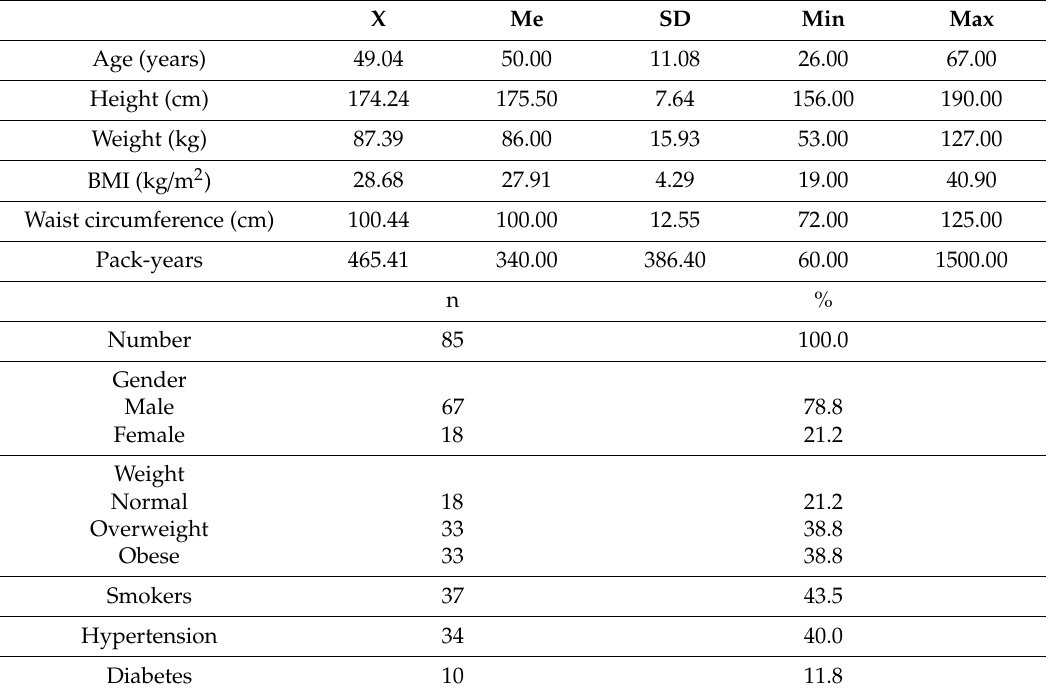
Table 1. Clinical characteristics of the study